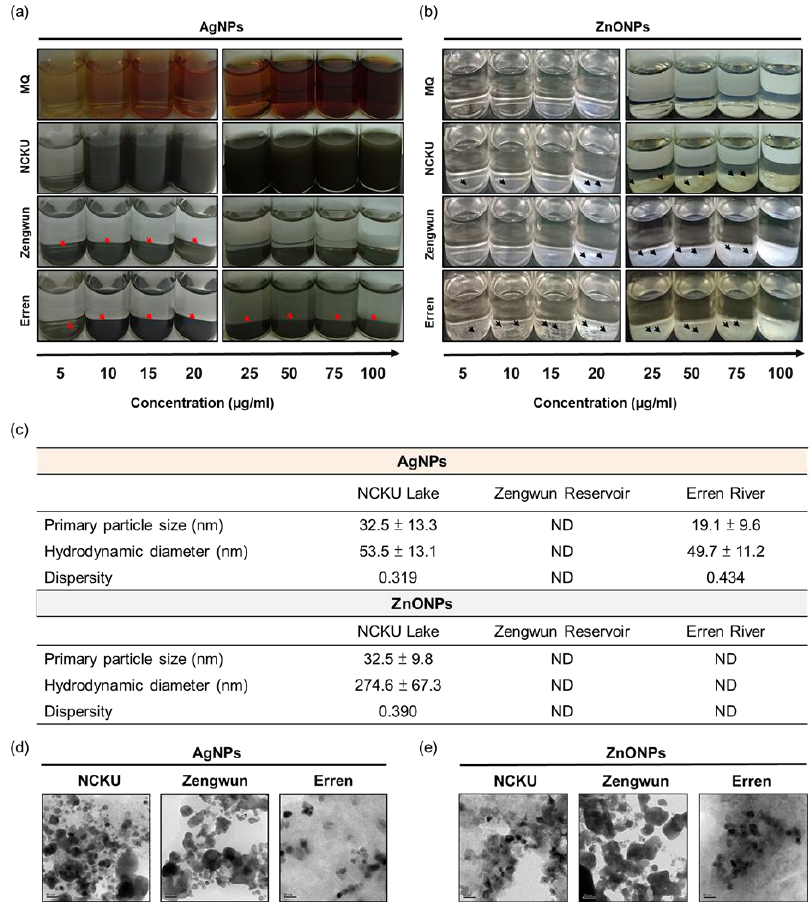
Figure 2. Deposition of AgNPs and ZnONPs spiked in natural water. The deposition of 5, 10, 15, 20, 25, 50, 75, and 100 µg/mL ( a ) AgNPs and ( b ) ZnONPs spiked in natural water from NCKU Lake, Zengwun Reservoir, and Erren River. Ag/ZnONPs aggregated and deposited at the bottom of the vessel. The arrow indicates Ag/ZnONPs deposition. ( c ) The physical and chemical properties of AgNPs and ZnONPs spiked in natural water. ( d , e ) TEM images of AgNPs and ZnONPs spiked in natural water. AgNPs and ZnONPs aggregated after spiking in natural water samples. AgNPs, silver nanoparticles; ZnONPs, zinc oxide nanoparticles; TEM, transmission electron